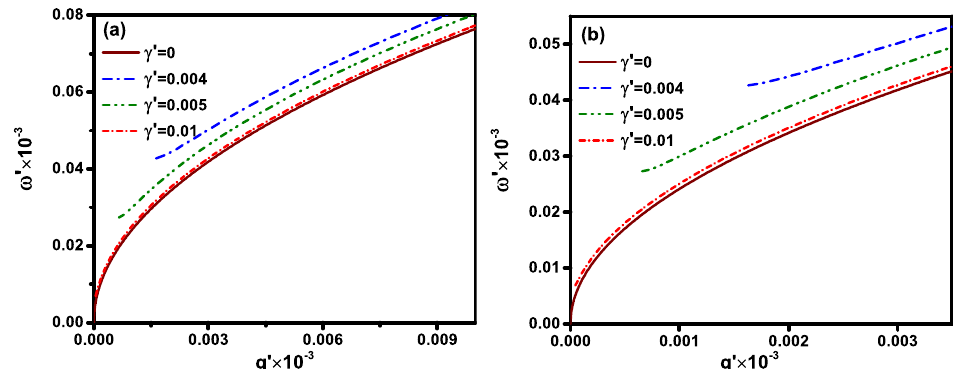
Figure 4. ( a ) SB TM SP for different values of γ (cid:48) . ( b ) The segment of (a) for q (cid:48) × 10 − 3 ≤ 0.0035.